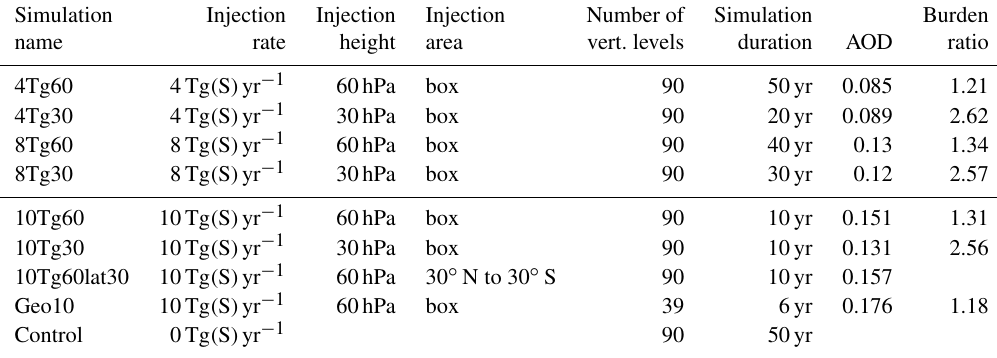
Table 1. Overview of the parameters for the simulations performed with ECHAM5-HAM. The injection rate differs between the simulations, as well as injection area and height. Box is one grid box at the equator at 120.9 to 123.75 ◦ E and equator to 2.8 ◦ N. The injection area 30 ◦ N to 30 ◦ S has in longitudinal direction also the width of one grid box. Furthermore, the globally averaged aerosol optical depth (AOD) and the ratio of the sulfate burdens in the tropics (10 ◦ N to 10 ◦ S) to extratropics (30 to 90 ◦ ) are